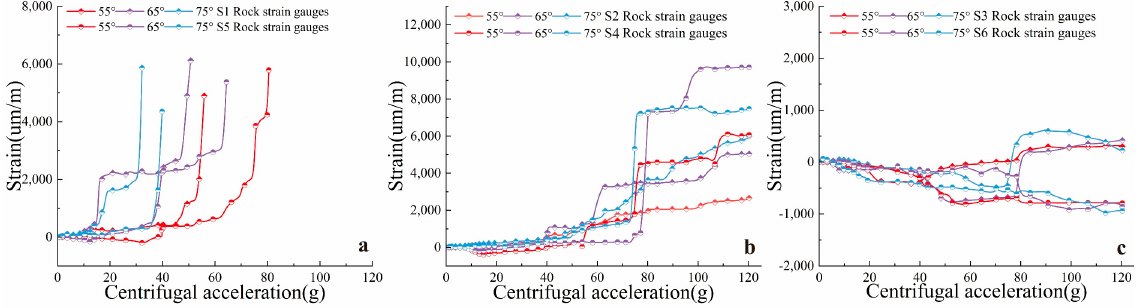
Figure 11. Model slope strain curves. ( a ) S1 and S5 strain curve, ( b ) S2 and S4 strain curve, ( c ) S3 and S6 strain curve.